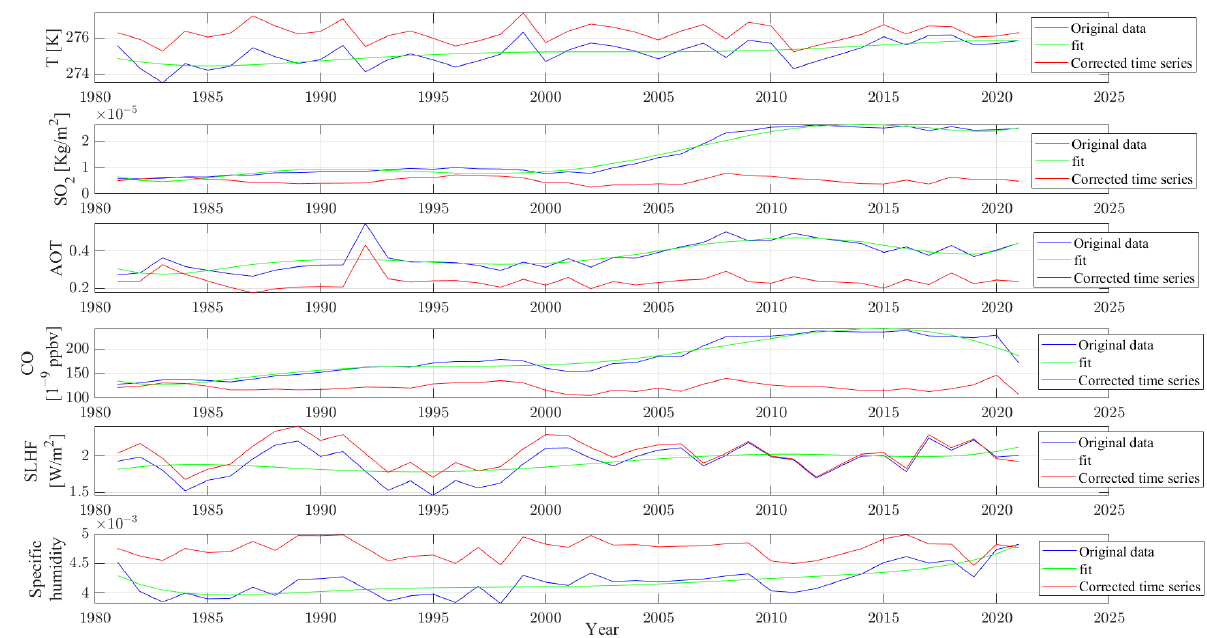
Figure 3. Atmospheric time series (blue line) of the yearly mean value (during the six analyzed months) for Temperature (T), SO 2 , aerosol (AOT), CO, surface latent energy flux (SLHF), and specific humidity from 1981 to 2021. The year of the earthquake (2013) is excluded from these graphs. A polynomial fit of degree 6 was performed and plotted as a green line, and the original data without the fit, i.e., the corrected time series, are plotted as red lines.